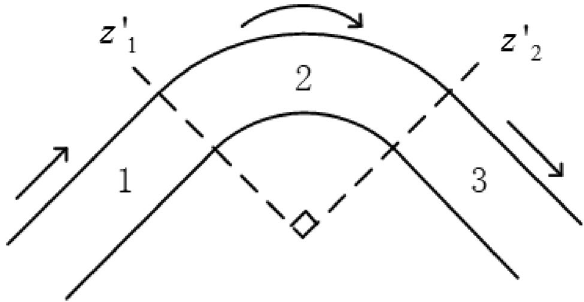
Figure 4. Schematic of guided wave traveling through a